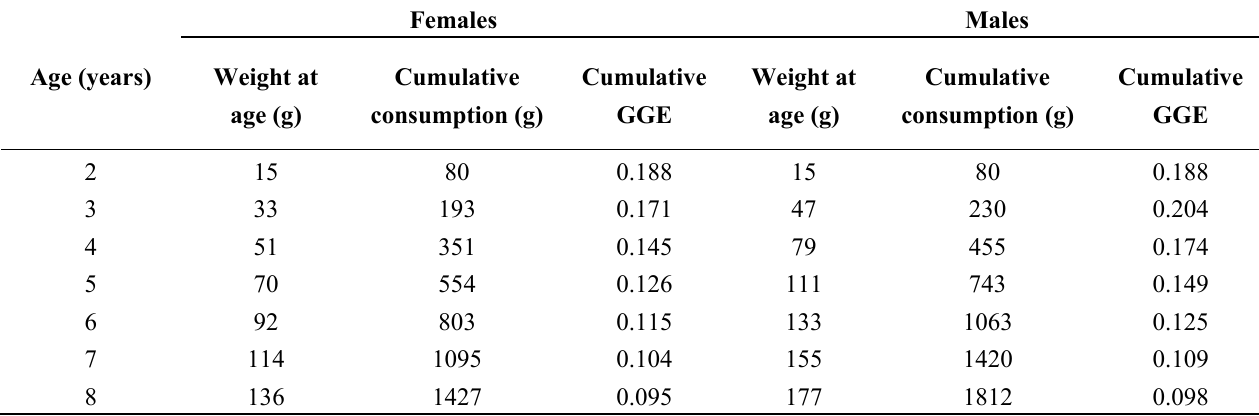
Table 2. Cumulative consumption and cumulative gross growth efficiency (GGE), by age and sex, for bluegills from Squaw Lake (Oakland County, MI, USA).